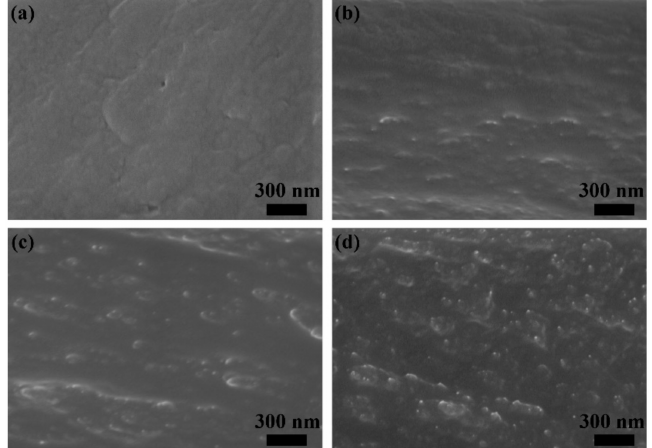
Figure 4. The cross section FESEM images of ( a ) SPI-BFDA-1, ( b ) SPI-BFDA-3, ( c ) SPI-BFDA-5, and ( d )